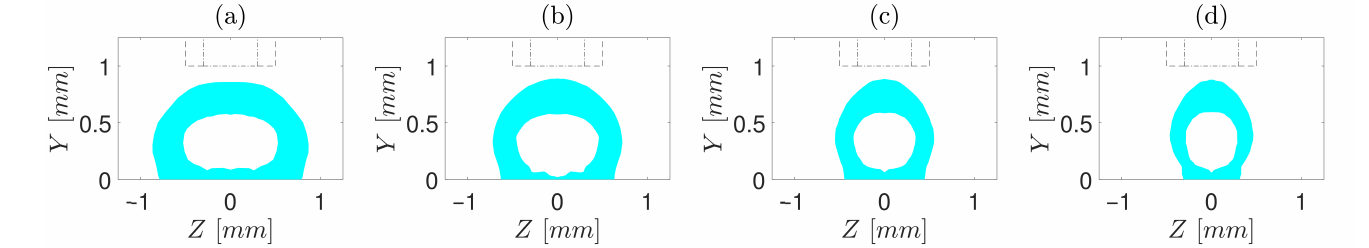
Figure 9. Cross-sections of the core–shell strand for t / D = 1, d / D = 0.6 and different V / U of ( a ) 0.5, ( b ) 0.75, ( c ) 1, and ( d ) 1.25. Core diameter and orifice are marked by “- -” and “-·”, respectively.